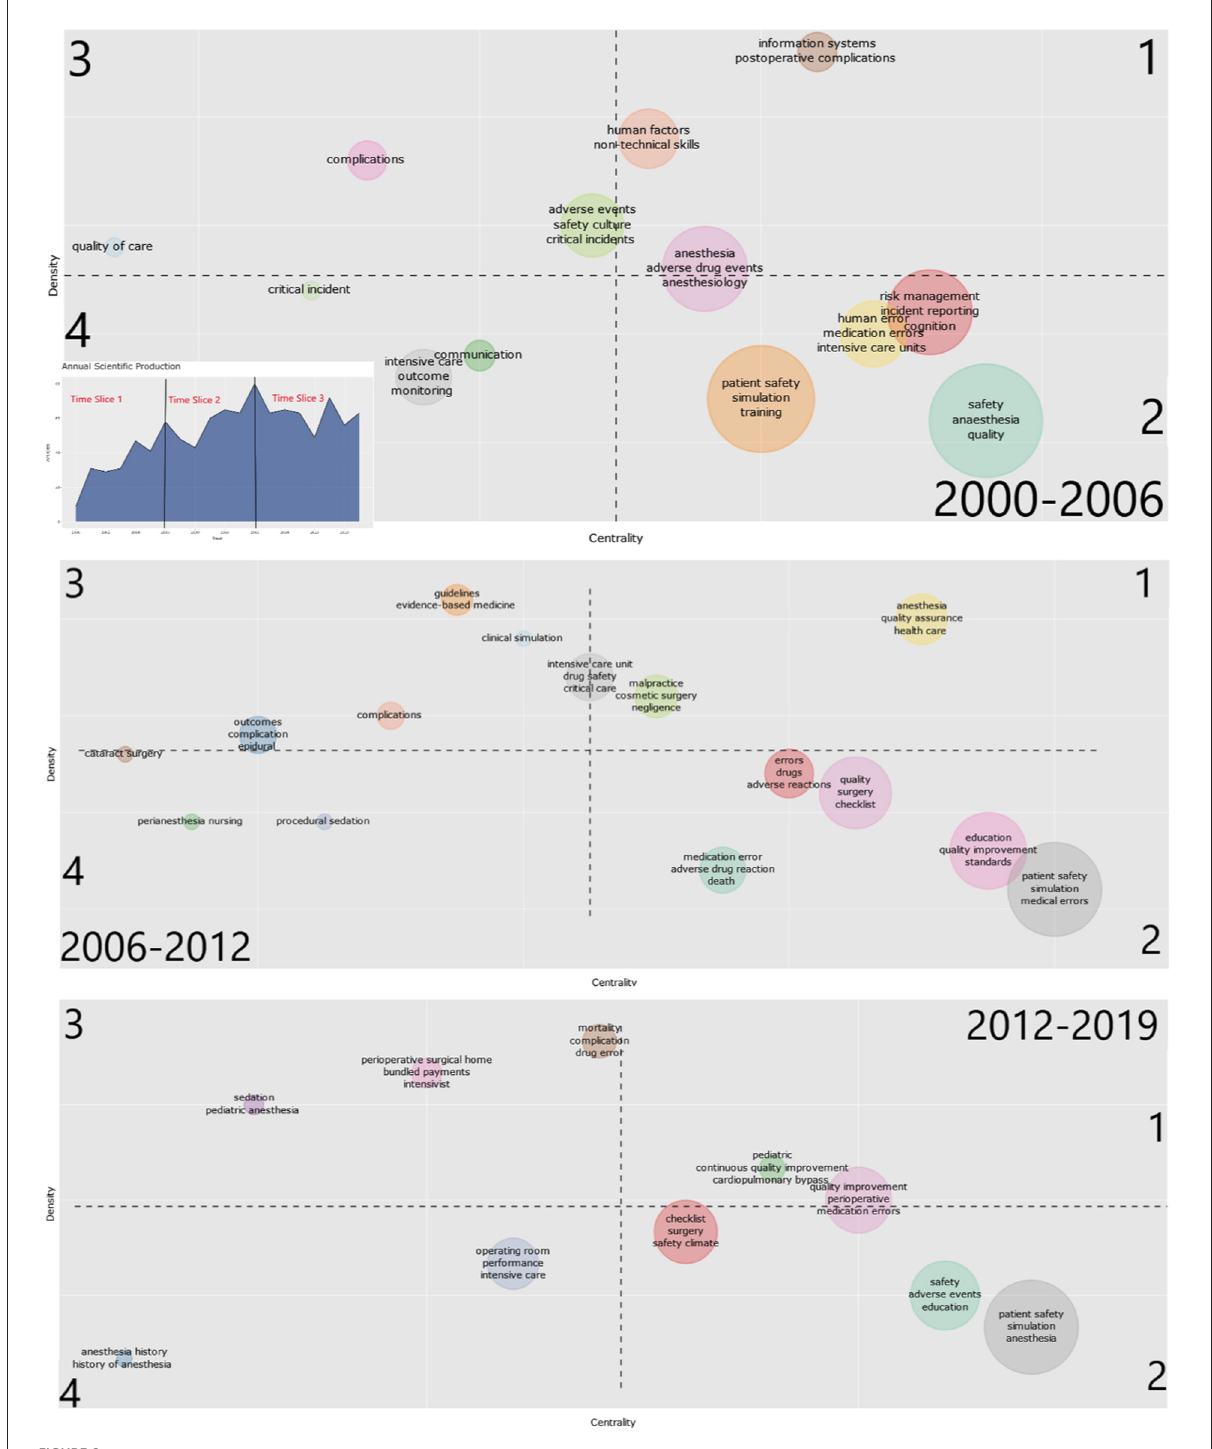
FIGURE6 Strategic diagram of the 2000–2006, 2006–2012, and 2012–2019 sub-periods. The numbers indicate the type of clusters defined by their centrality and density as proposed by Michel Callon (80). Each cluster is labeled with the corresponding three most frequent keywords within the cluster. Inserted figure: Distribution of documents per year with 2 cutting points at the two publication peaks in 2006 and 2012. The cluster colors were randomly assigned by biblioshiny and therefore differ across